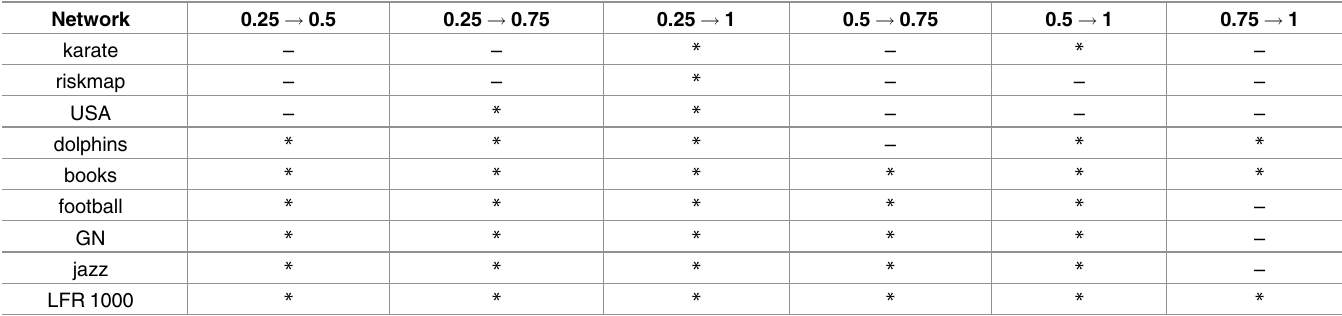
Table 3. Wilcoxon sum-rank results regarding differences in payoff function calls for the tested p values. An * indicates significant difference.